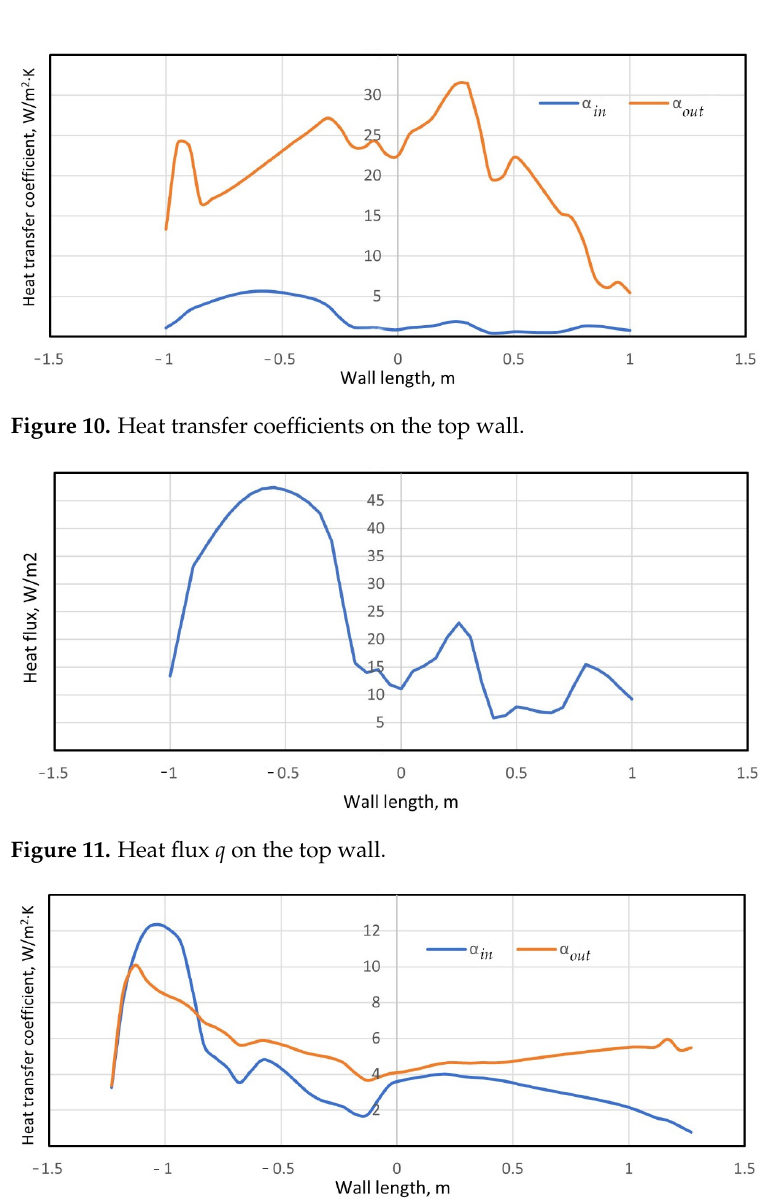
10 of 20 Figure 8. Heat transfer coefficients on the left wall .